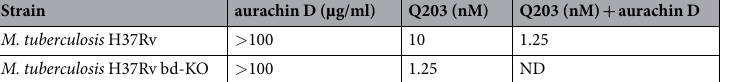
Table 1. In vitro susceptibility of Mycobacterium tuberculosis for Q203 and aurachin D. Minimal inhibitory concentrations (MICs) for M. tuberculosis reference strain H37Rv and a M. tuberculosis strain lacking cytochrome bd 27 were determined using the reazurin method. Q203 + aurachin D represents the MIC for Q203 in the presence of 25 μ g/ml aurachin